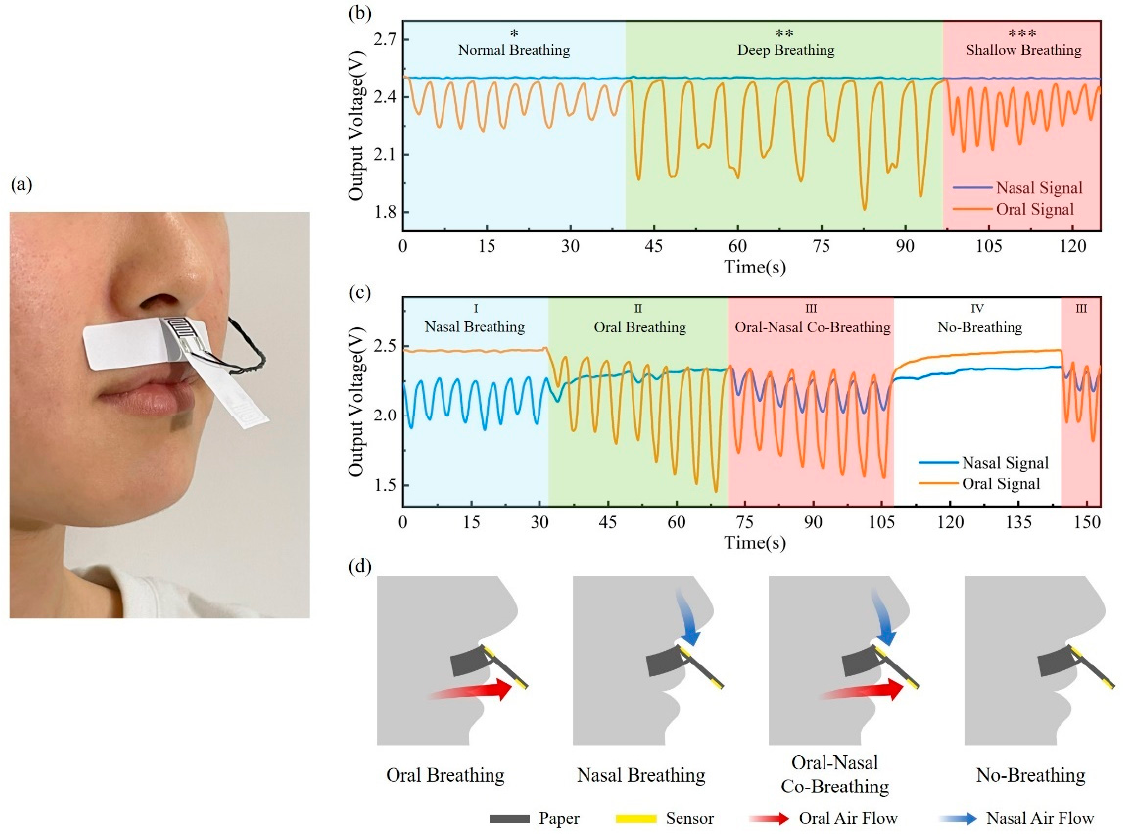
Figure 4. ( a ) Photo of a volunteer wearing a PHS patch. ( b , c ) Simulated breathing experiments for different breathing modes and various respiratory patterns (*: normal breathing; **: deep breathing; ***: shallow breathing). ( d ) Schematic diagram of oral and nasal airflows in four respiratory patterns.